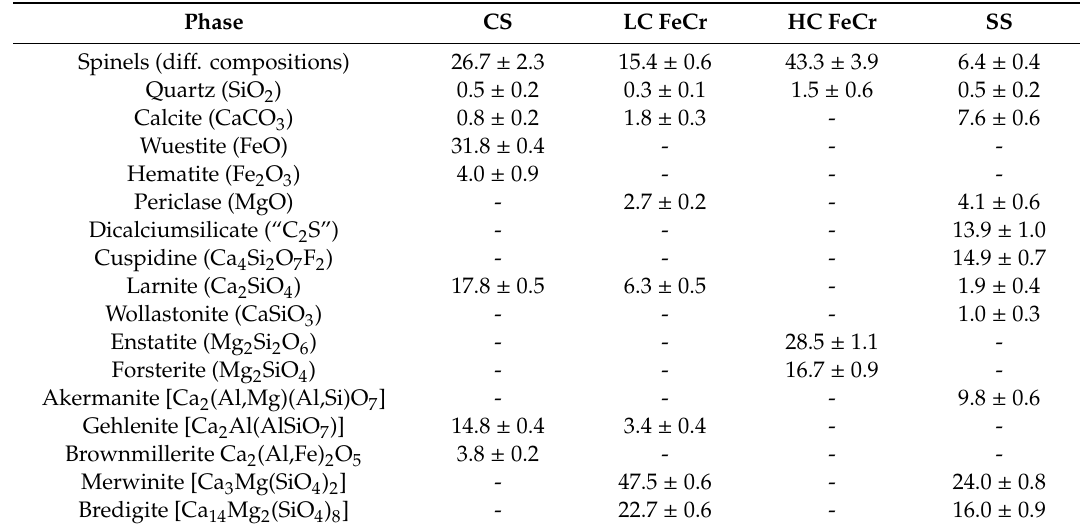
Table 2. Results from X-ray di ff raction (Rietveld method), showing the mineral phases within the slags (crystalline parts only, values given in wt %); for details about the spinels, see the text. CS: carbon steel slags, LC FeCr: low-carbon ferrochrome, HC FeCr: high-carbon ferrochrome, SS: stainless steel slags. Phase CS LC FeCr Spinels (di ff . compositions)